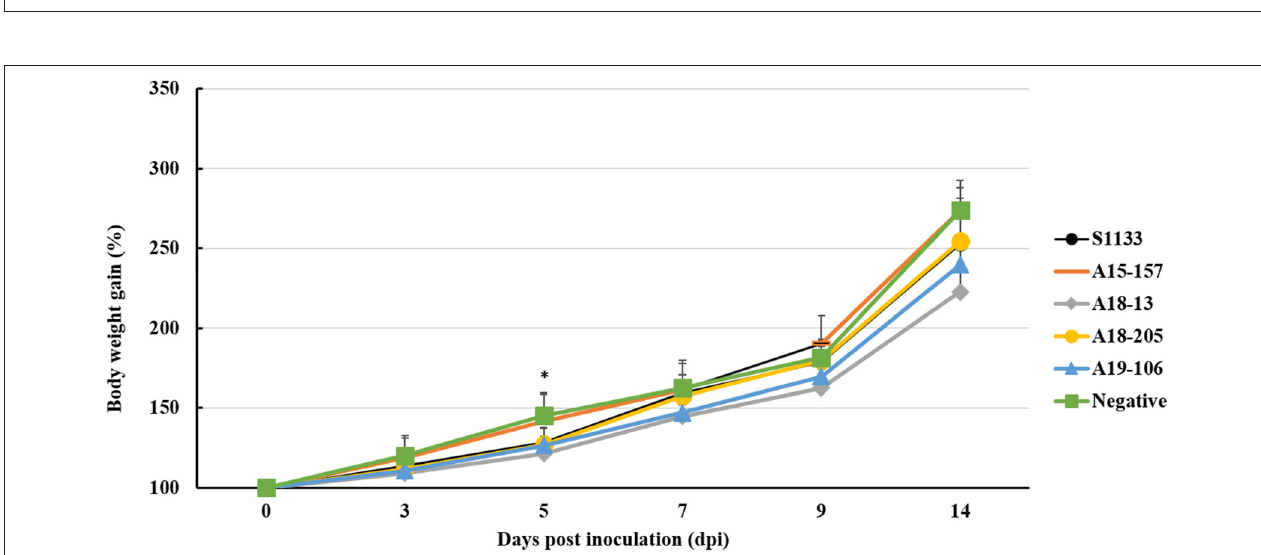
FIGURE 2 | Body weight changes of chickens infected with ARV by footpad route. The ARV-infected groups were infected with 10 6 TCID 50 /0.1mL of ARV. The negative control group was inoculated with 0.1ml PBS. Bars show mean ± SD. The mean value was statistically significant, determined using one-way ANOVA followed by Tukey’s post-hoc (P < 0.05). Asterisk (*) indicates p < 0.05 and represents a significant difference between the negative control (PBS) group and virus-infected